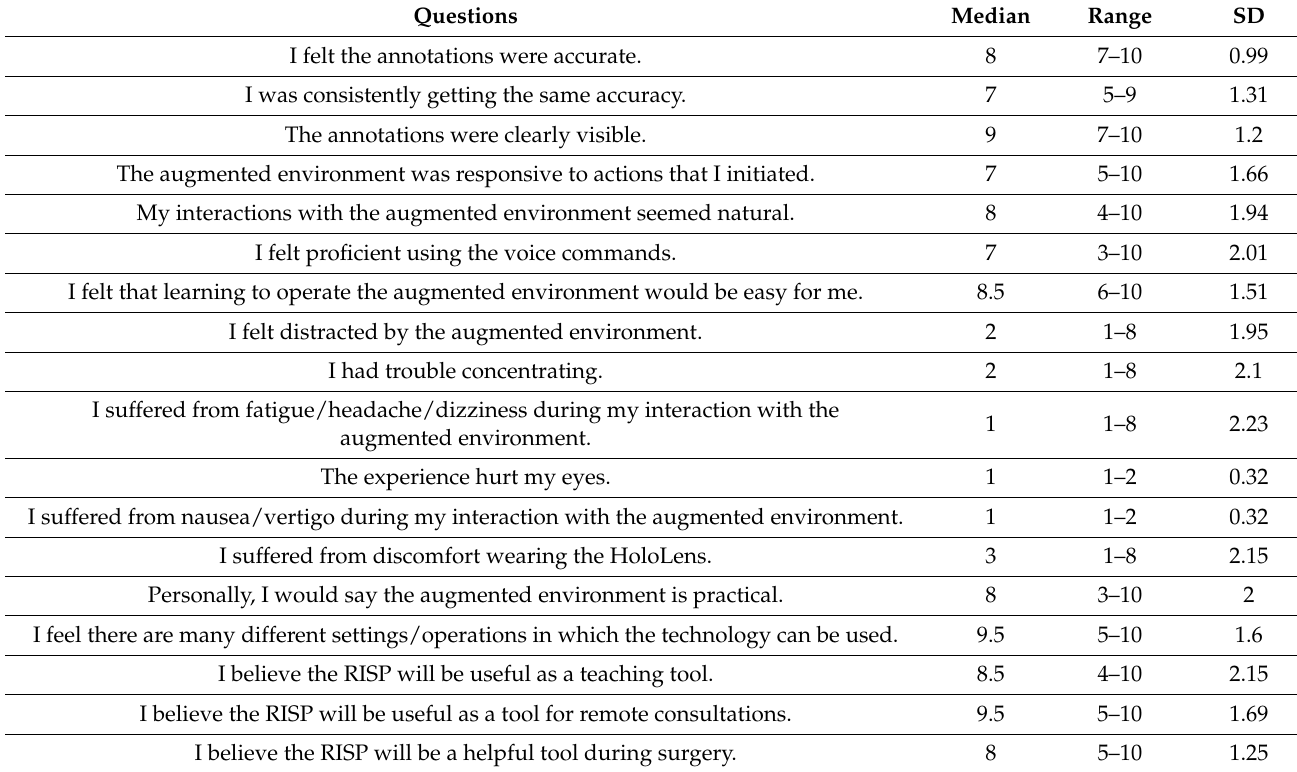
Table 2. Mean score and SD to statements from the questionnaire. Score: 1 = not at all, 10 =